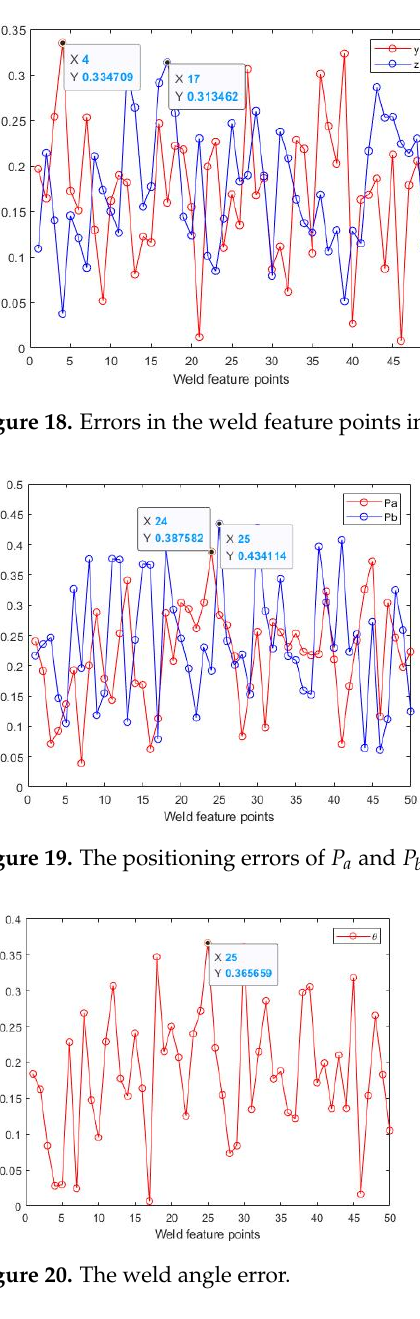
Figure 17. The auxiliary positioning tool.